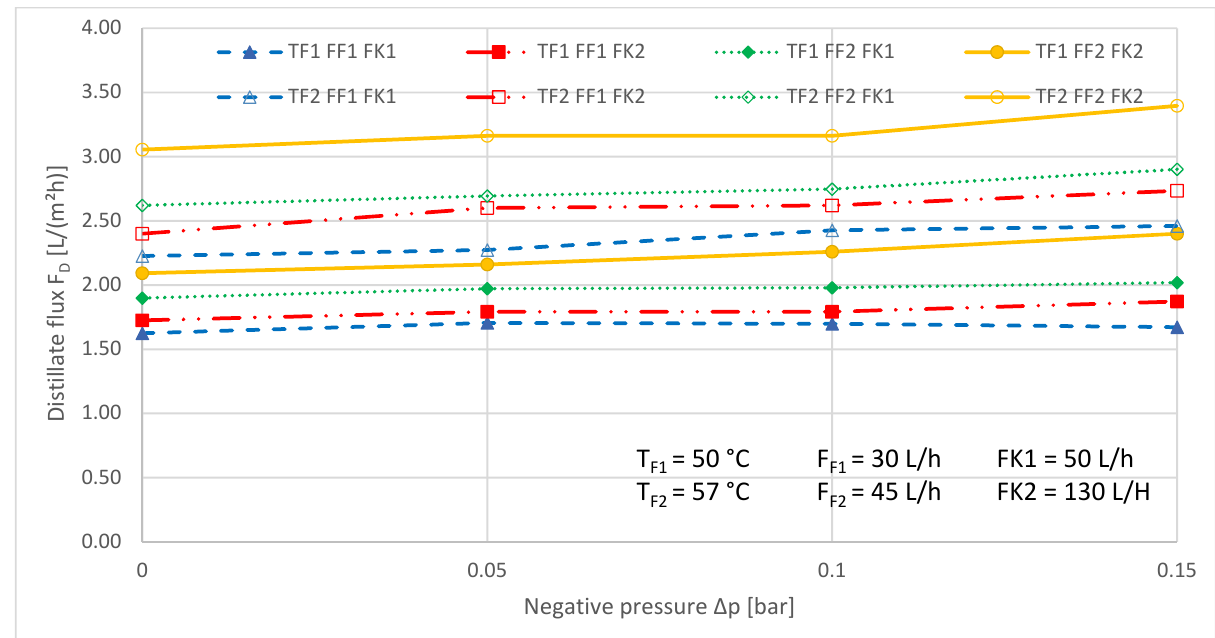
Figure 7. Distillate flux as a function of the applied negative pressure during VMD. T F = const., F F = const., F K = const. during the respective measurement series. The numbers refer to the different levels, low (1) and medium (2), described in